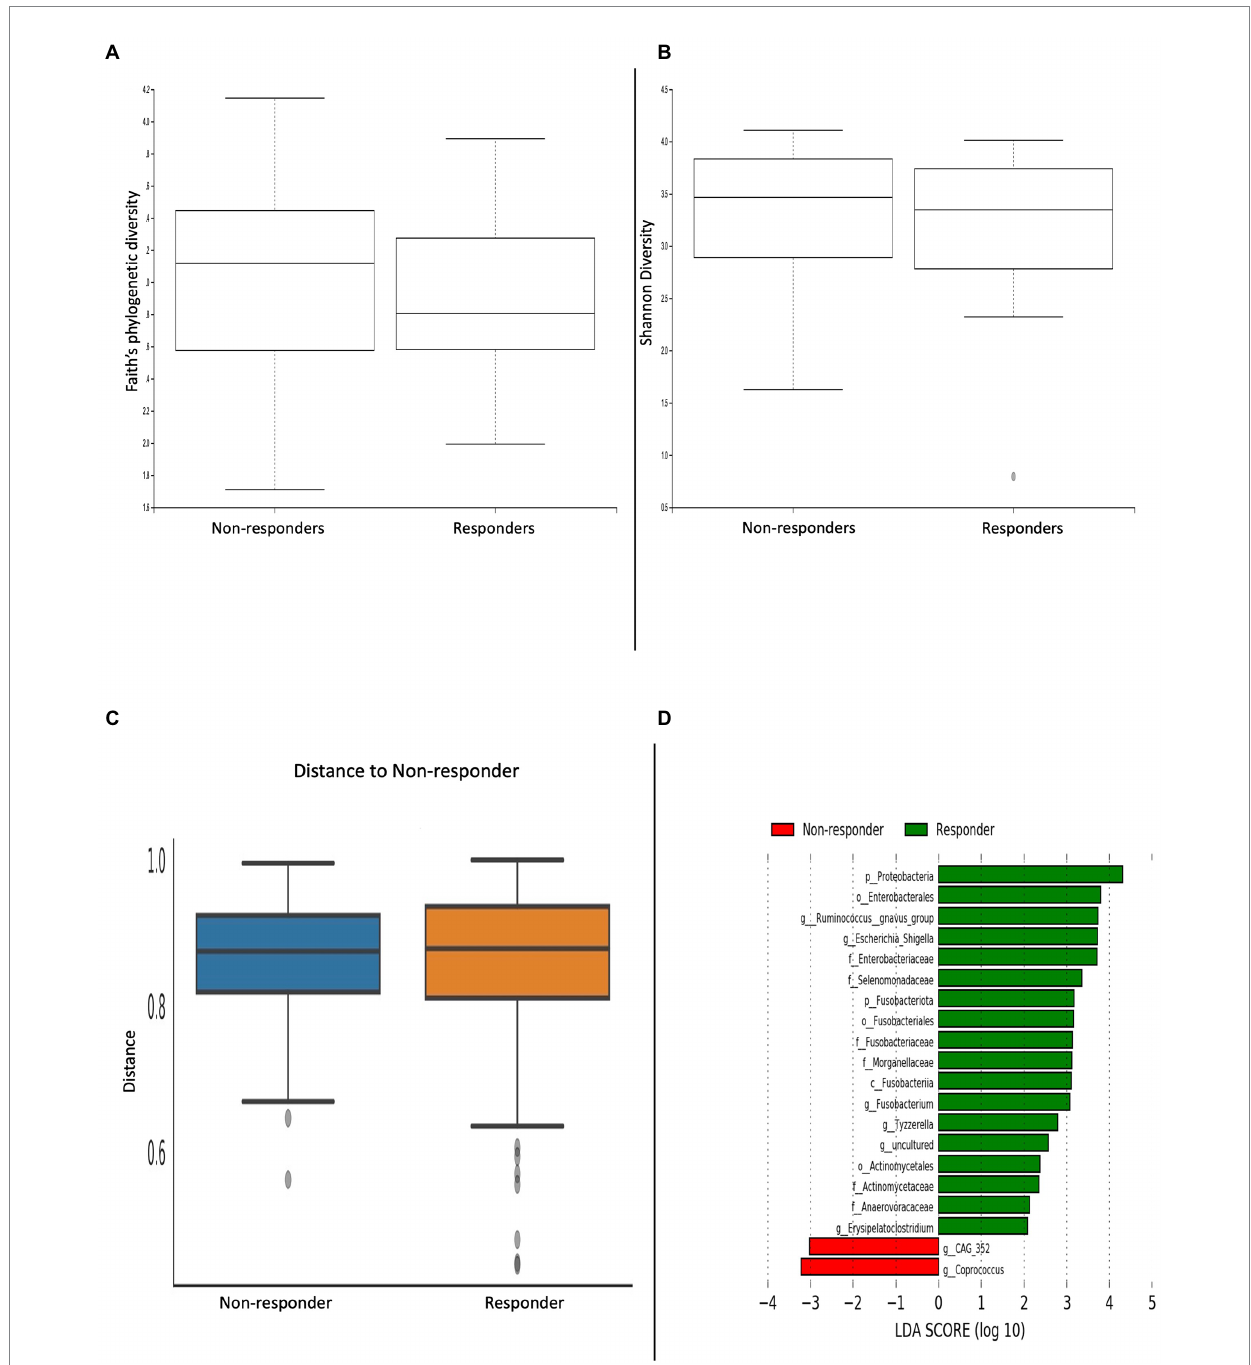
FIGURE 5 Microbial differences comparing clinical responders versus non-responders. α -diversity metrics (A) Faith’s phylogenetic diversity and (B) Shannon diversity were non-significant. (C) Bray-curtis distance matrix β -diversity metric was non-significant. (D) LEfSE histogram of LDA scores for differentially abundant bacterial taxa between responders and non-responders. Taxa highlighted in green was more significant in responders and red in non- responders. Taxa with an LDA >2 with a p -value ≤ 0.05 was considered statistically